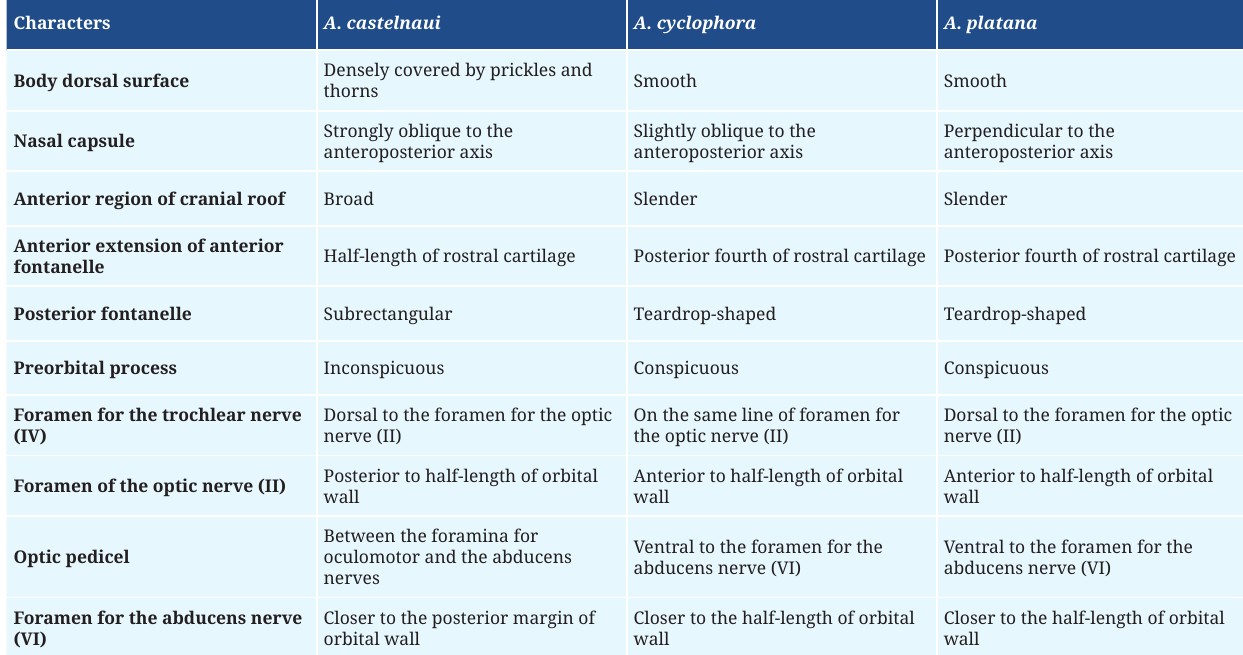
TABLE 8 | Summary of morphological differences observed among Atlantoraja